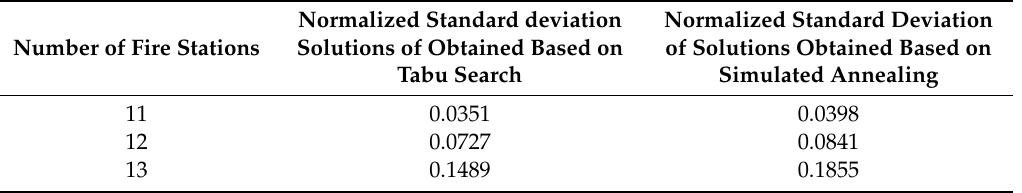
Table 16. The normalized standard deviation of solutions obtained using the VAOCMP model with both algorithms.